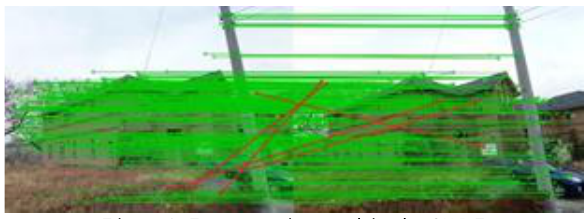
Figure 2. Feature points tracking by SURF